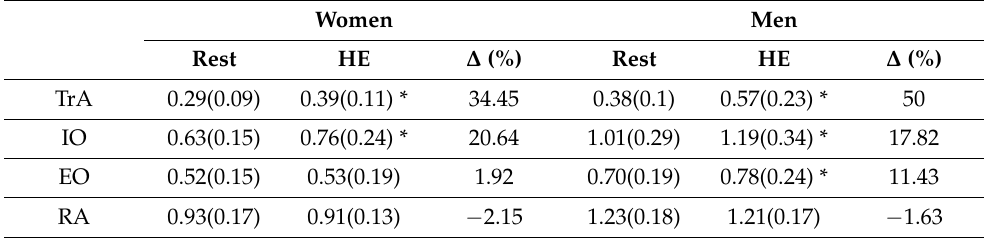
Table 2. Comparison between rest and HE in both sexes in supine mean (SD).